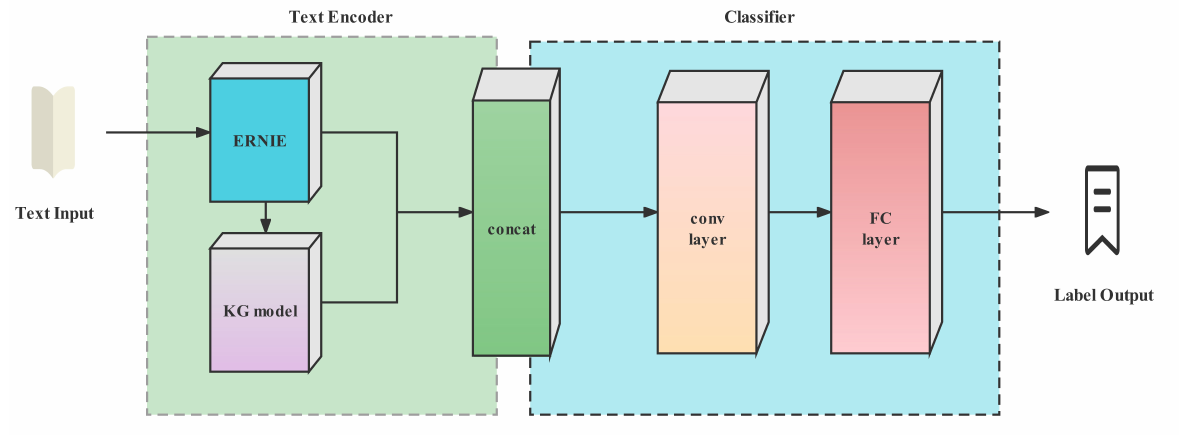
Figure 1. KG-ERNIE